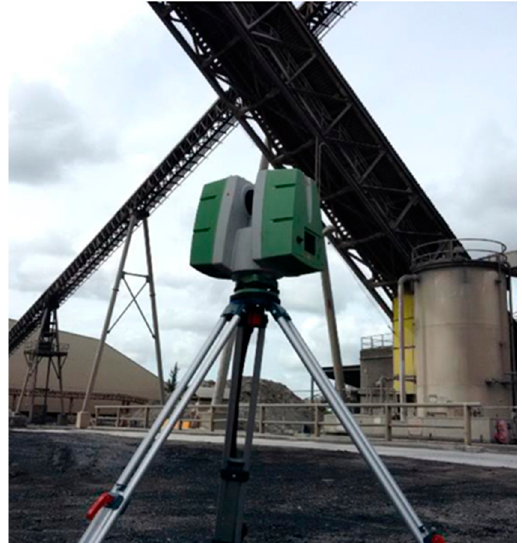
Figure 12. 3D laser scanner.